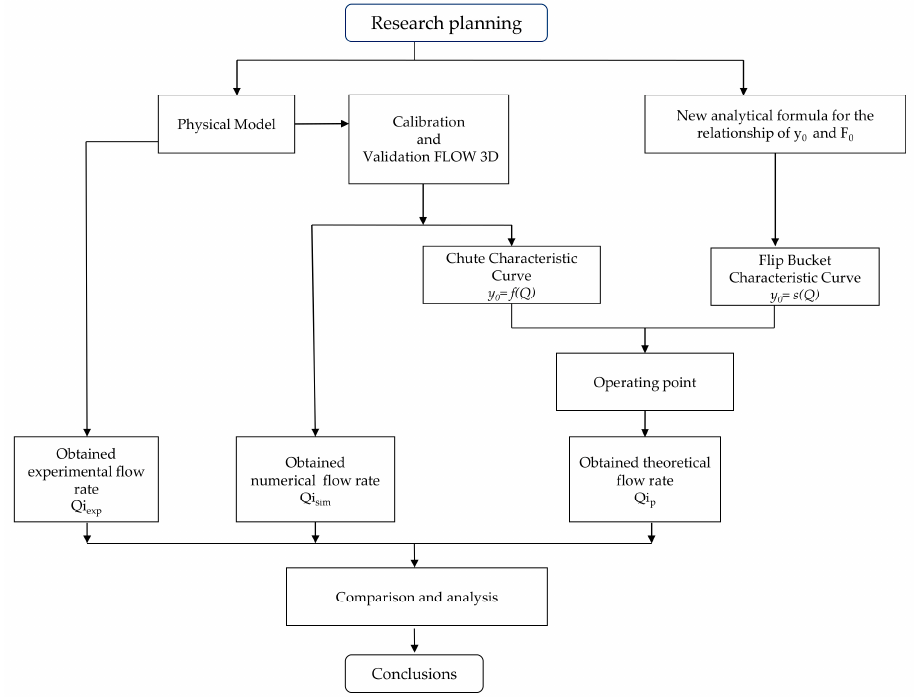
Figure 1. Workflow of the research.